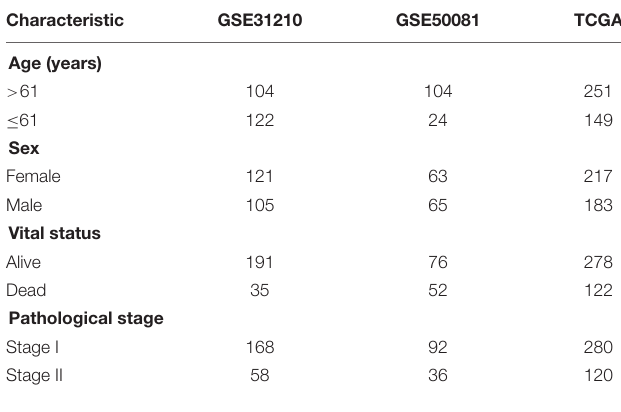
TABLE 1 | Clinical information of the Gene Expression Omnibus (GEO) and The Cancer Genome Atlas (TCGA) datasets.